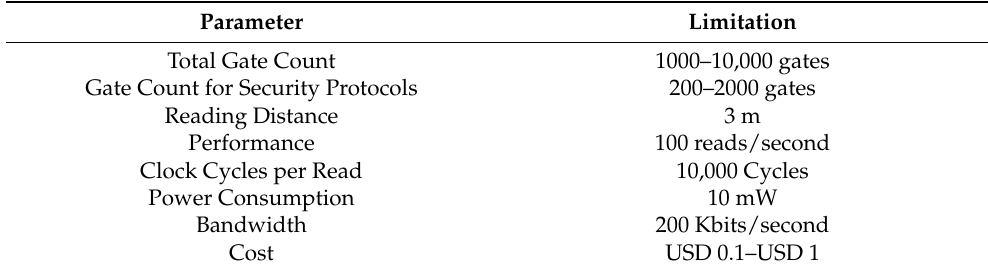
Table 1. Specifications of EPC-C1G2 RFID